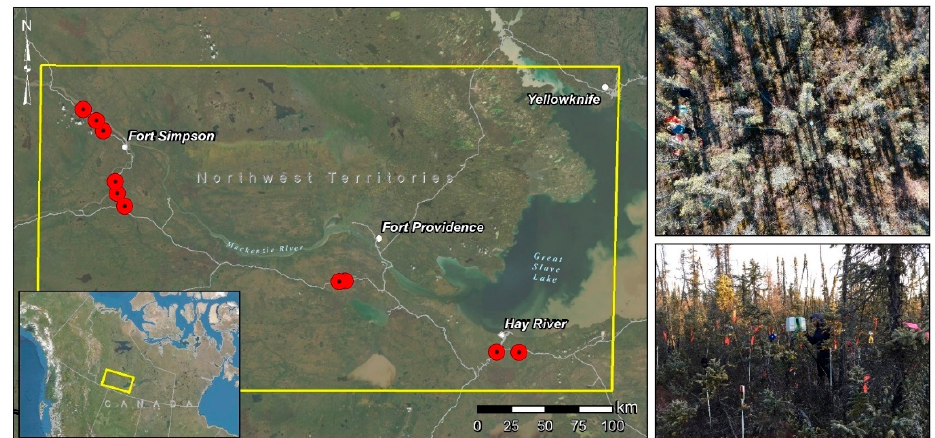
Figure 1. Field plots used in the study. Bottom left: Location of the study area within Canada. Centre: Location of the plots within the study area. Top right: A drone overhead view of one of the plots. Bottom right: Ground view of a plot, also Subfigure 2, 3. Scanning the Plots.